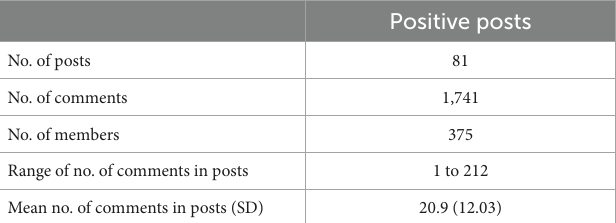
TABLE 2 Descriptive data for subreddits in Study